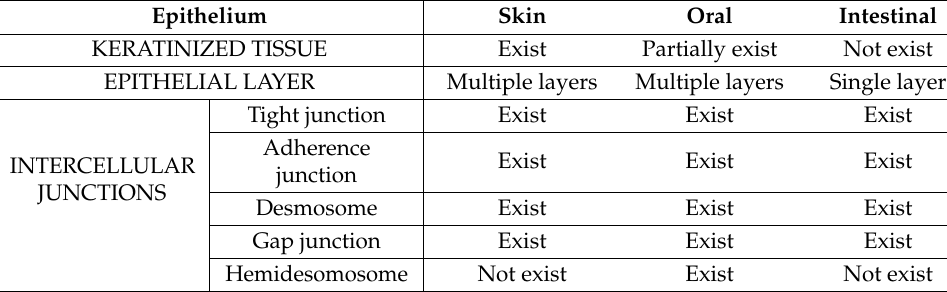
Table 1. Comparison of skin, oral mucosa, and intestinal